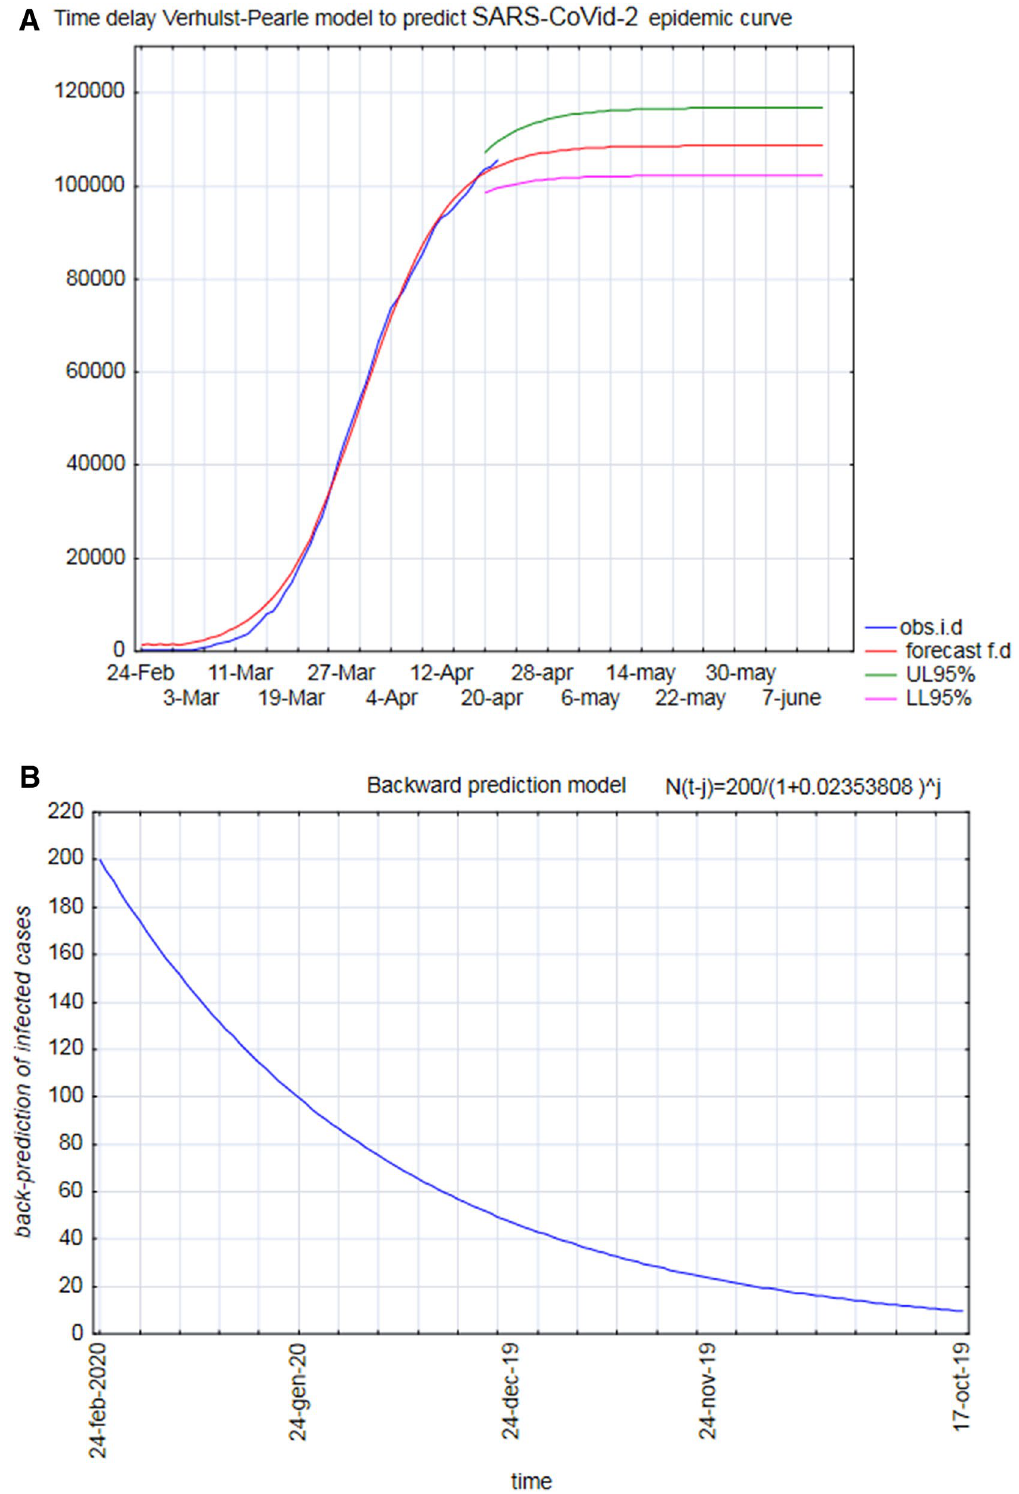
Figure 2. The figure reports the logistic model of epidemic cycle built upon the end of March 2020 data, with the indication of backward and forward prediction confidence intervals ( A ). (B) Focuses on backward prediction pointing to the very beginning of epidemic in October